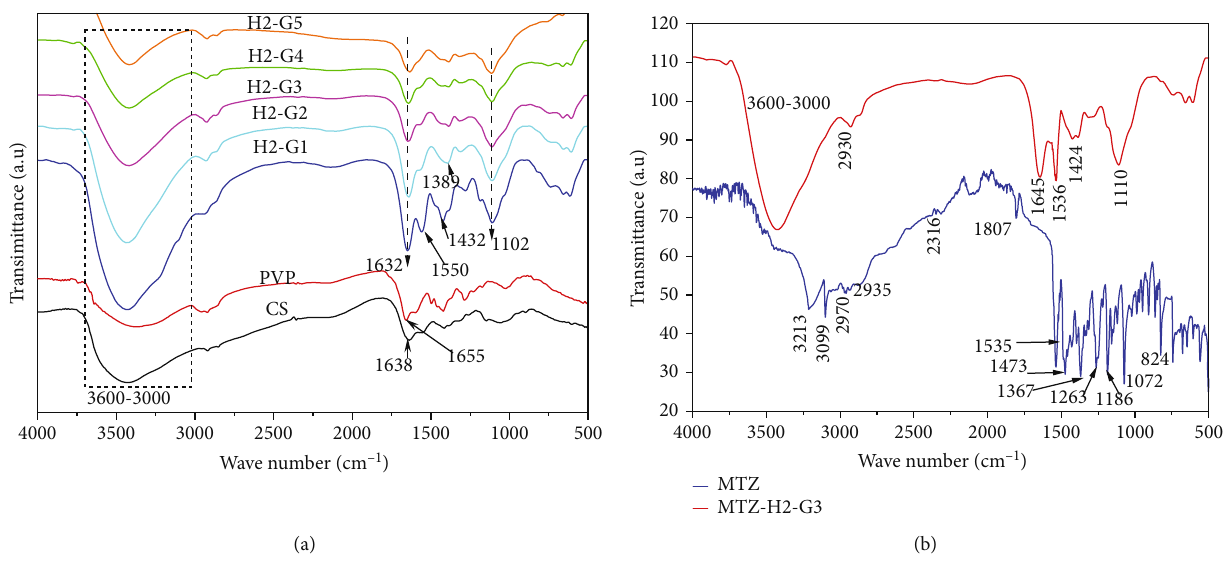
Figure 4: FTIR spectra of (a) pristine CS, PVP, and hydrogels H1-G1 to H2-G5 (b) pristine MTZ and hydrogel